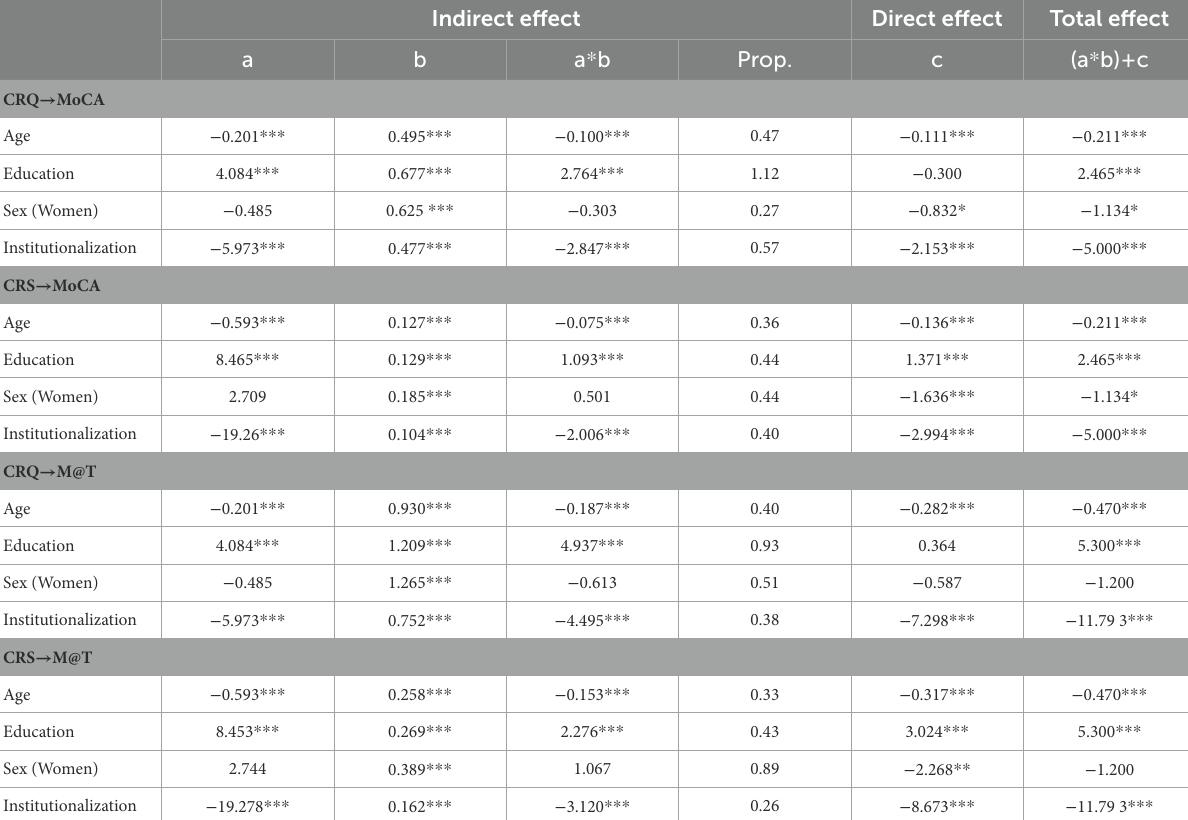
TABLE 1 Mediation analysis of the four sociodemographic predictors of cognitive performance (assessed with MoCA and M@T) contrasted with cognitive reserve as a mediating variable (assessed with CRQ and